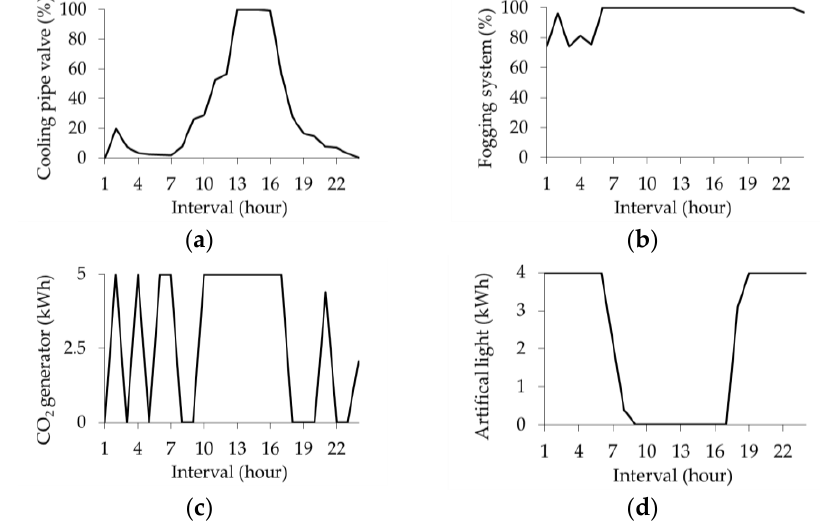
Figure 5. Equipment usage for environment control in a building microgrid with rooftop greenhouse: ( a ) Cooling pipe valve; ( b ) Fogging system; ( c ) CO 2 generator; ( d ) Artificial light.